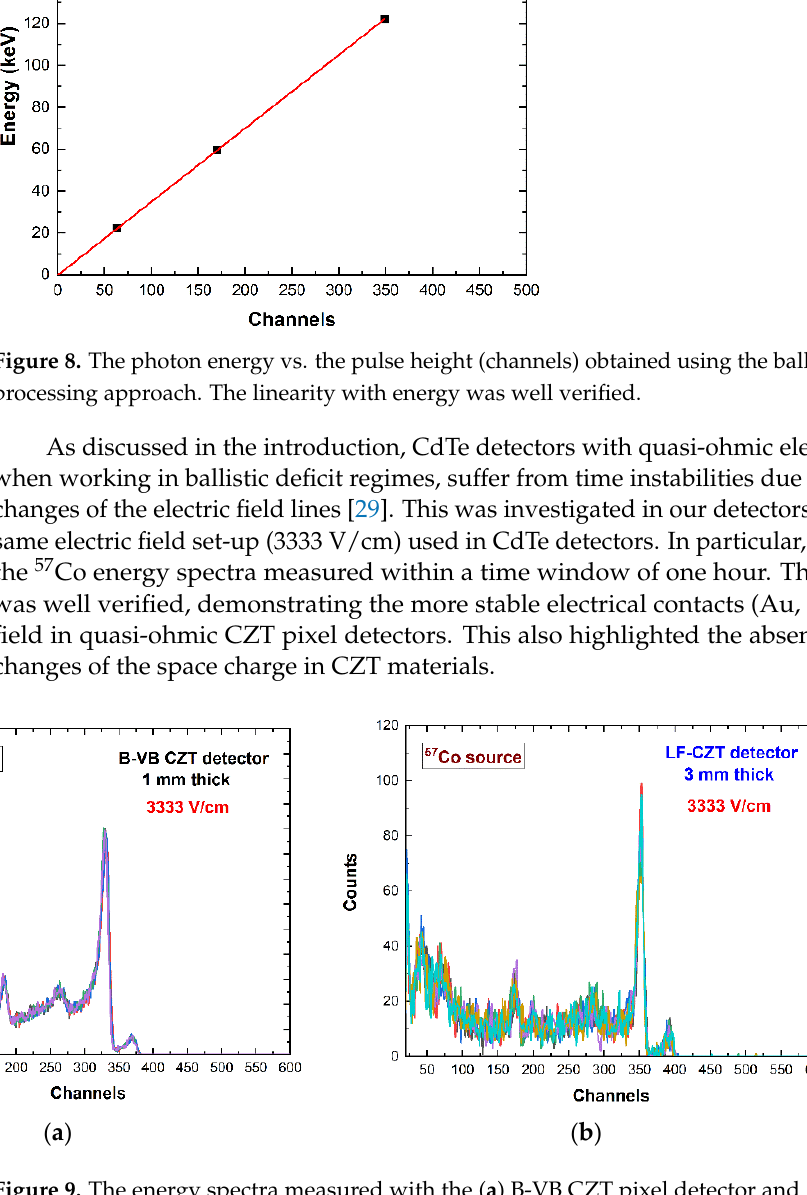
9 of 16 Figure 7. Measured ( a , c , e ) 109 Cd and ( b , d , f ) 57 Co energy spectra for the three CZT pixel detectors. All spectra were obtained using the ballistic deficit pulse processing with a peaking time T S of 30 ns (dead time of 90 ns). Excellent energy resolution of 3.6% FWHM at 122 keV was obtained with the 3-mm CZT pixel detector. This was an interesting result when compared with the energy reso- lution of about 8% at 122 keV for the 3-mm CdTe pixel detectors using similar ballistic